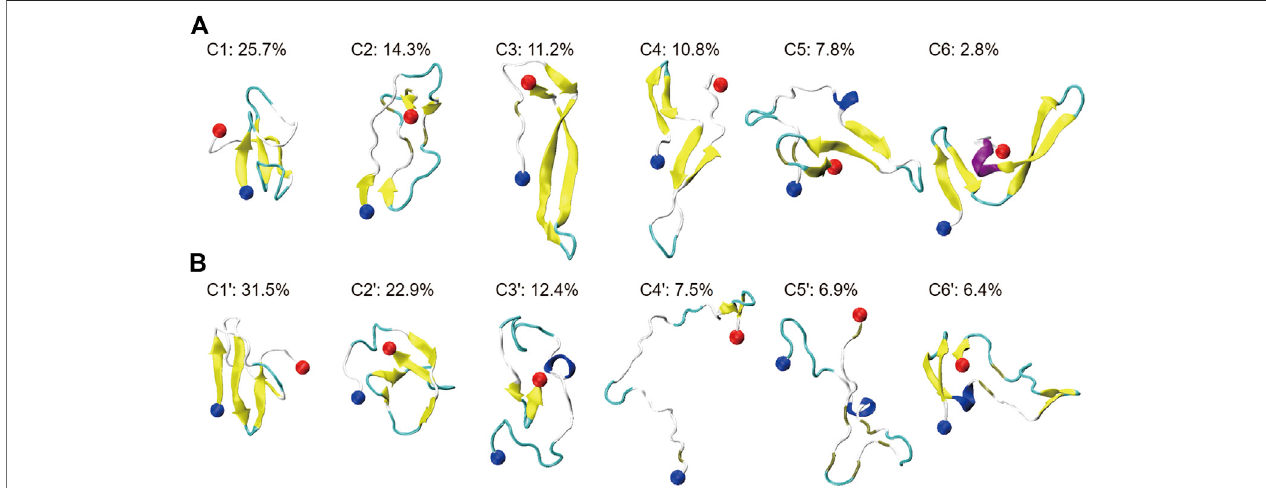
FIGURE 2 | Cluster analysis on the conformational ensemble of the A β 42 peptide in two systems: (A) A β 42 and (B) A β 42 + HSA. For two systems, representative conformations of the A β 42 molecule in the top six most-populated clusters are shown as well as the corresponding population of each cluster. The blue and red balls refer to the C α atoms of the N- and C-terminal residues (D1 and A42),